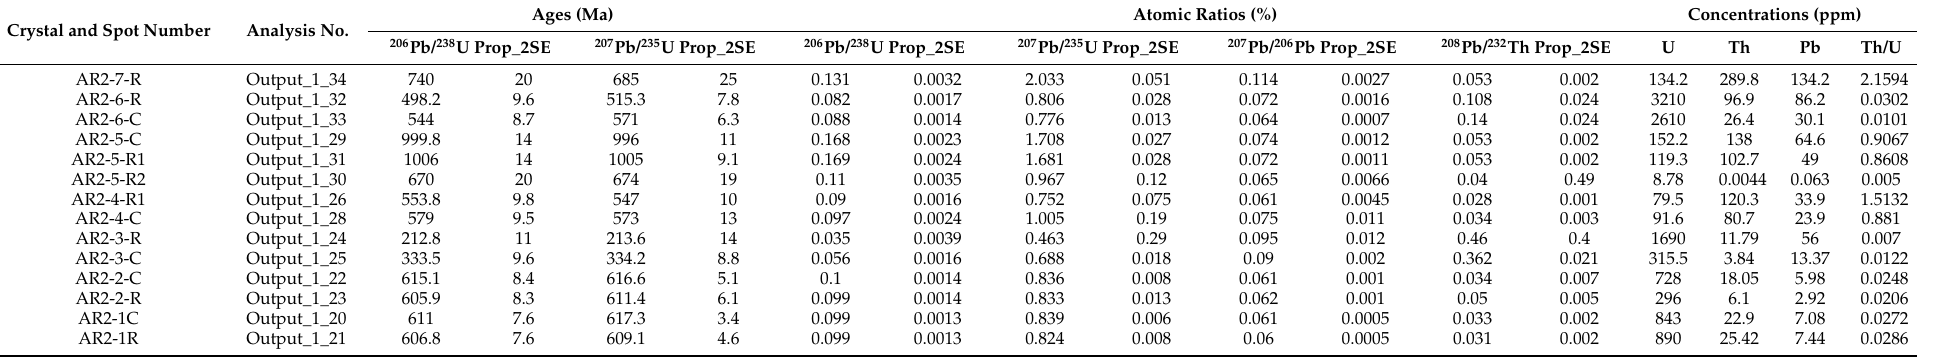
Table 3. Trace element and U-Pb isotopic results (zircon from Araru whitish-grey gneiss) with C and R in the spotted